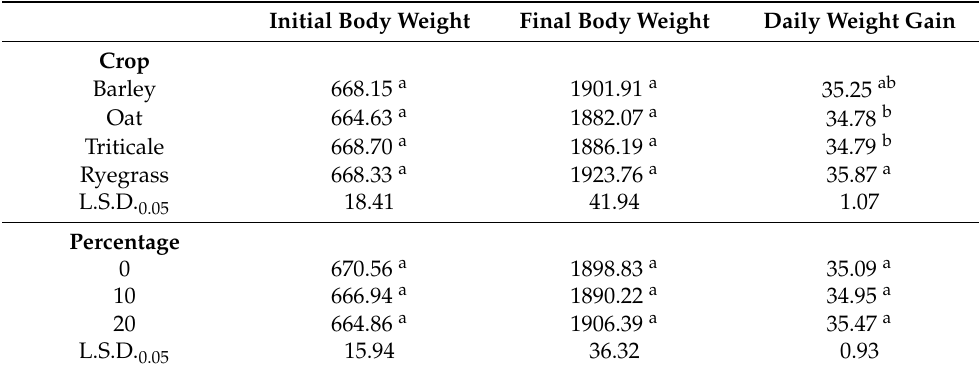
Table 3. Means of the initial and final weight, daily weight gain (g) as affected by the crop and its percentage in the